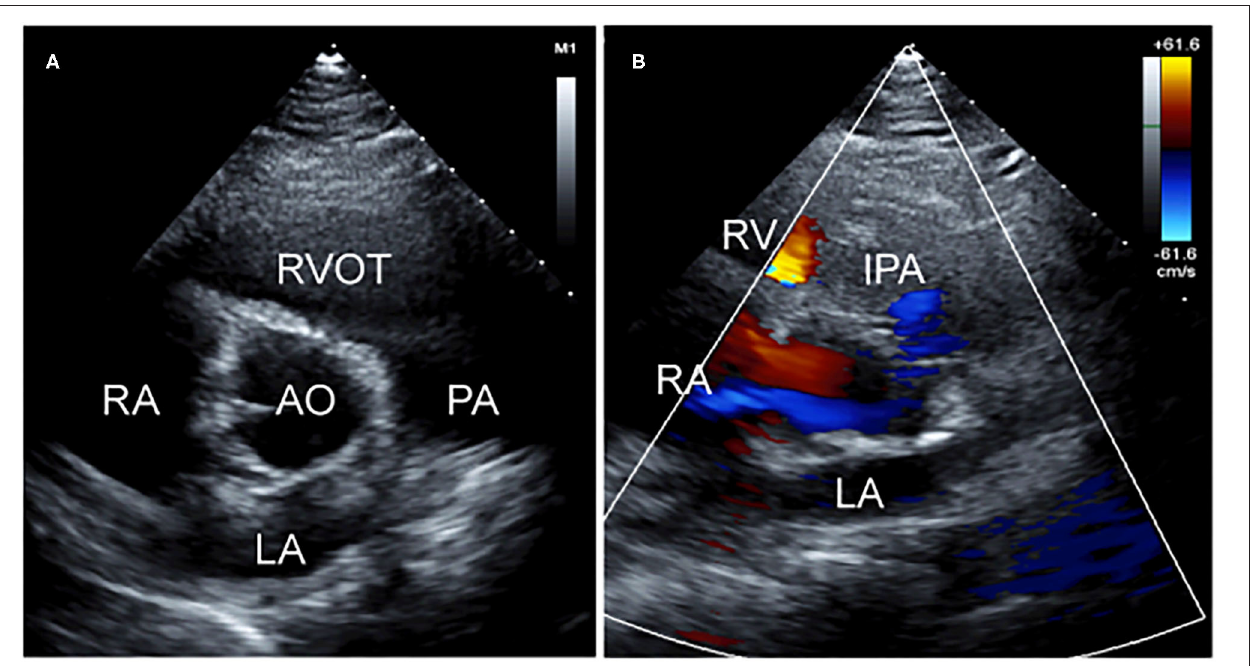
FIGURE 3 | Post-operation two-dimensional transthoracic echocardiographic images. (A) Short-axis view at the aortic valve level showing the perforation of the left sinus of Valsalva repair and (B) non-standard short-axis view showing the cessation of abnormal blood flow on color Doppler.